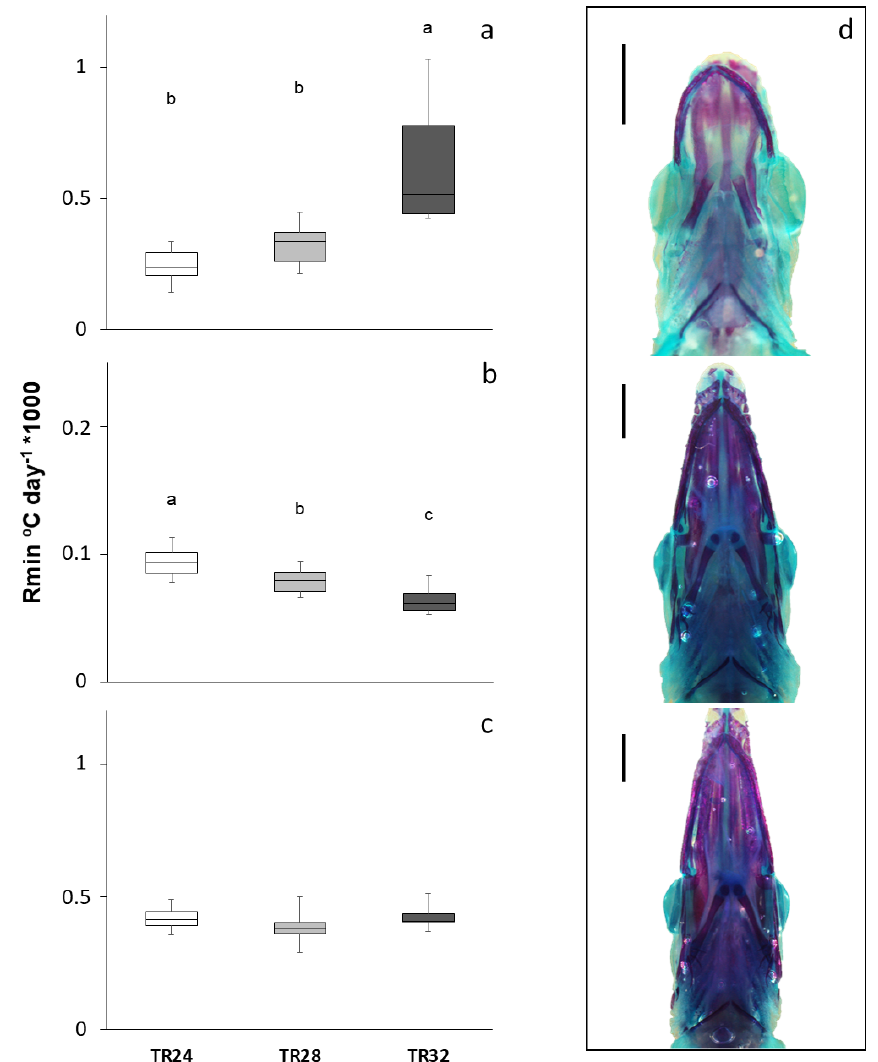
Figure 5. Skeletal development degree rates (expressed as median ± max/min values) per °C day (Rmin °C day − 1 × 1000) in Atractosteus tropicus larvae when embryos were incubated at different thermal regimens. Cartilage quantity (ratio of blue stained surface over total larval surface) at hatching ( a ) and 16 ( b ) days post-fertilization (dpf); and bone structures (ratio of red stained surface over total larval surface) at 16 ( c ) dpf. Examples of tropical gar juveniles stained with alcian blue and alizarin red (ventral view) showing progressive ossification of cranial bones ( d ). Different letters at the top of the boxes denote significant differences ( p < 0.05). Scale bar = 1